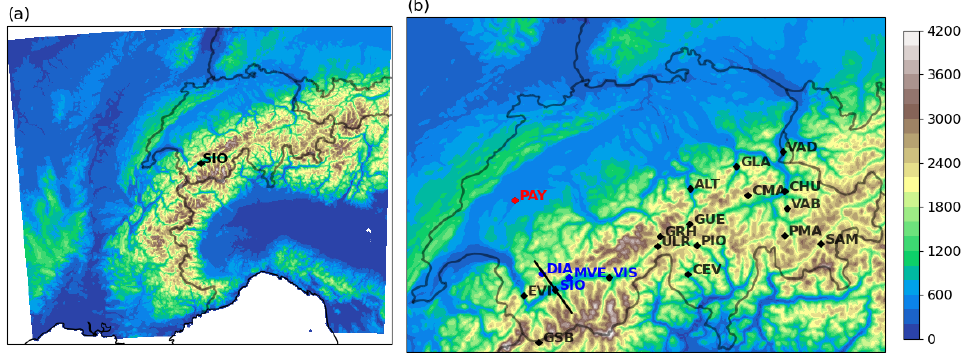
Figure 1. ( a ) Model integration domain and terrain height (m; shaded); ( b ) location of the diurnal wind stations available in September 2016 (black diamonds), of two extra stations in the Wallis (DIA, MVE), and of the site of the radiosonde ascent (PAY). Sion and three stations in the Wallis are highlighted in blue. The black line denotes the footprint of the vertical cross section discussed in Section